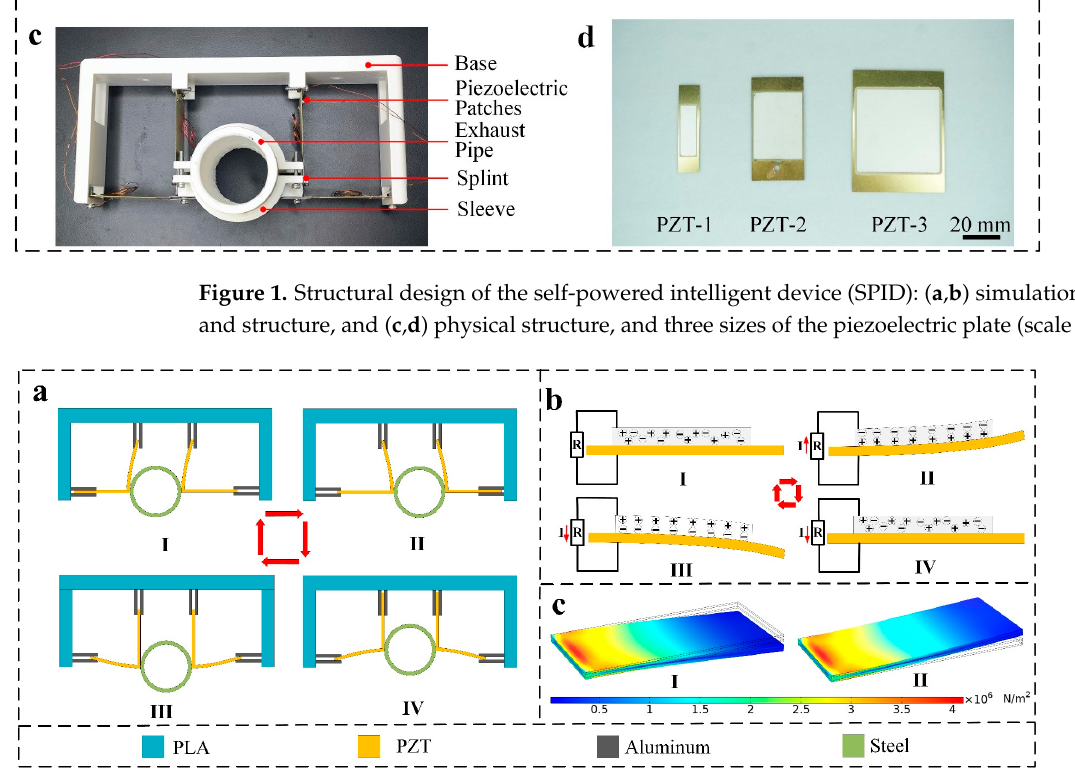
Figure 2. Working principle of the SPID: ( a ) schematic of the operating principle of the intelligent device, ( b ) deformation demonstration and electron distribution of piezoelectric plates, and ( c ) simulated potential distributions of the SPID in the two positional states.